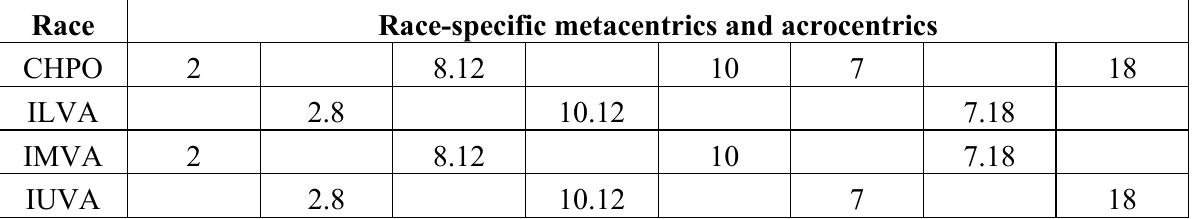
Table 2. Race-specific metacentrics and acrocentrics of chromosomal races in Upper Valtellina.